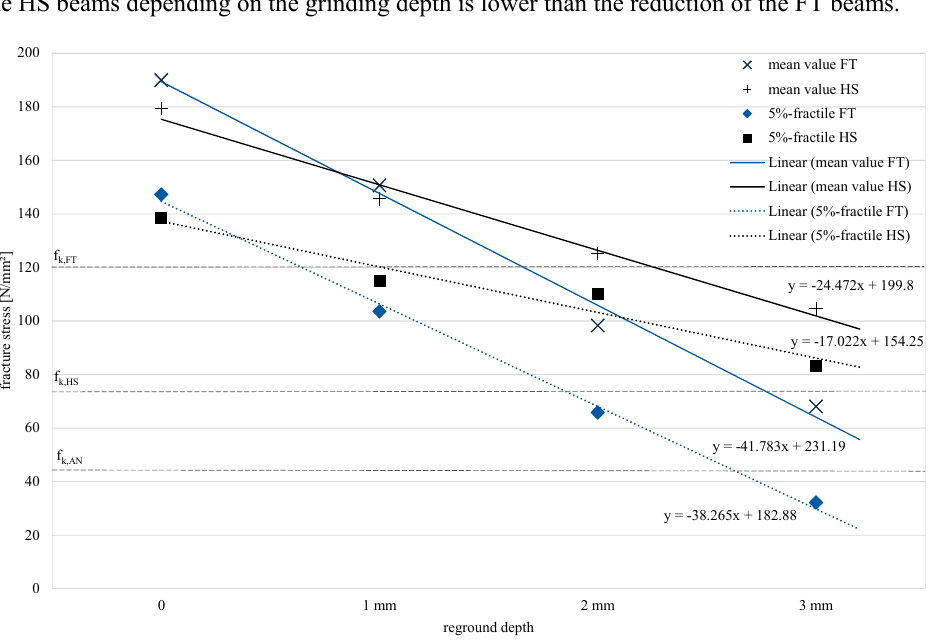
Fig. 11 Linear regression curves of mean value and 5 %-fractile depending on grinding depth regarding FT and